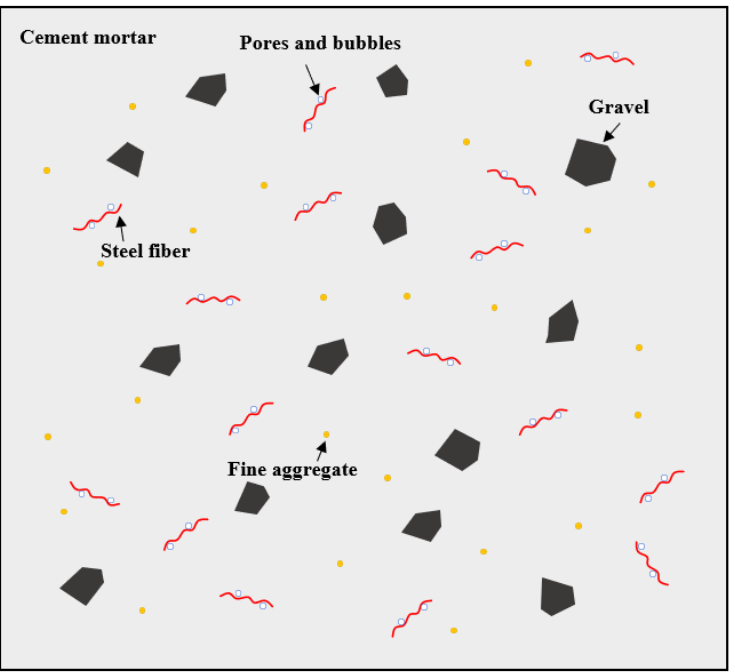
Figure 17. Internal structure of self-compacting gangue